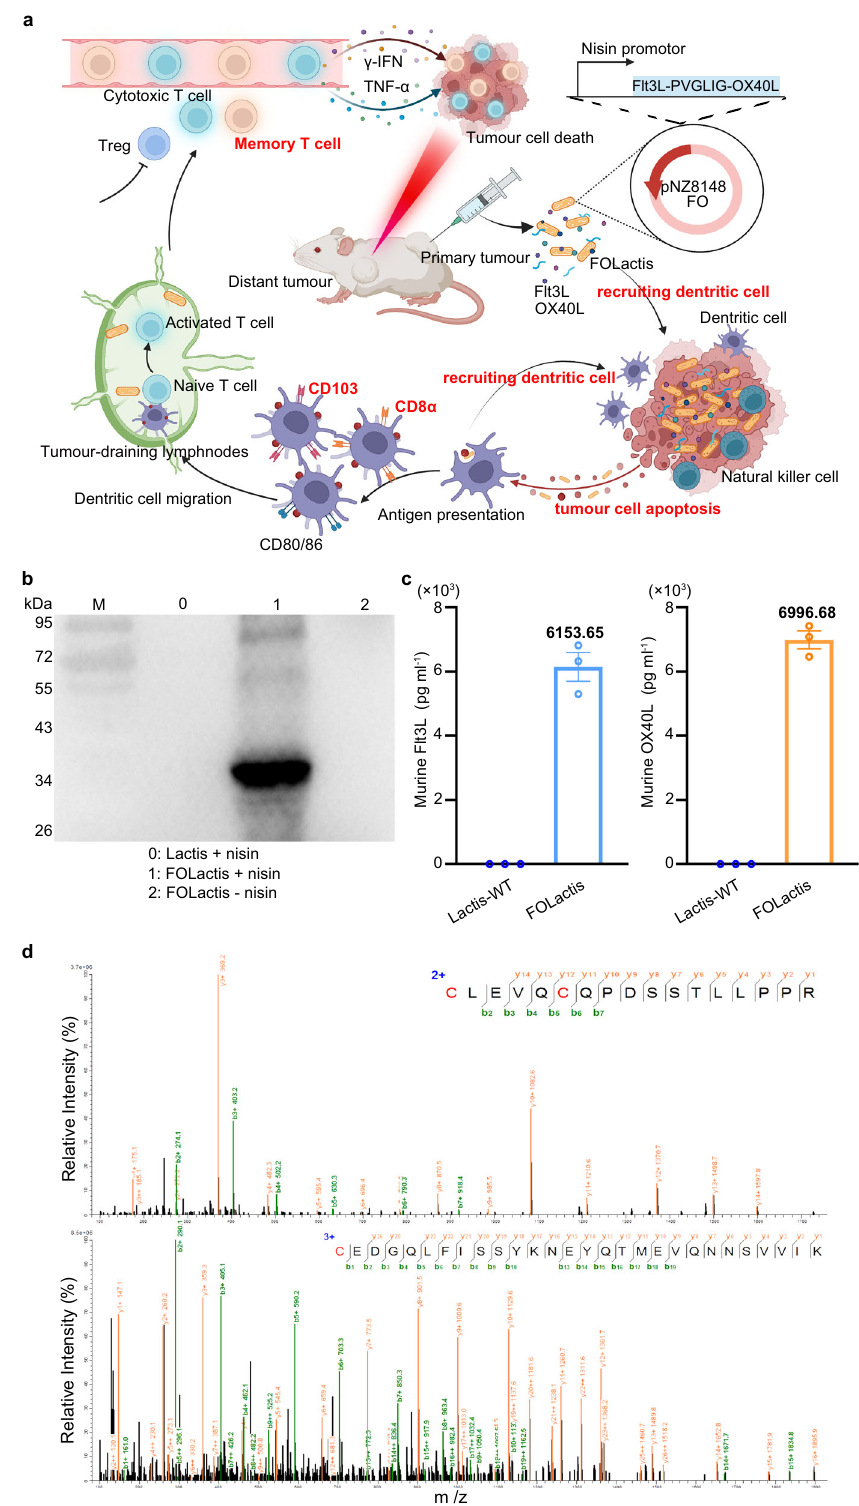
Fig. 1 | Construction of engineered Lactococcus lactis delivering Flt3L-OX40L fusion protein (FOLactis). a Schematic diagram of intratumourally injecting FOLactis to enhance tumor immunotherapy by reprogramming the immune microenvironment of local tumor and tumor-draining lymphnodes. Created with BioRender.com. b Western blotting analysis of the induced or non-induced engi- neered Lactococcus lactis (One representative data was shown from three inde- pendently repeated experiments). Nisin is an inducer of protein expression. M: